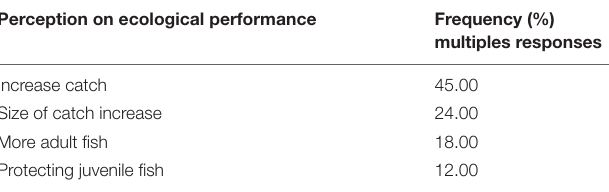
TABLE 5 | Perceptions of participants (survey) on ecological performance of seasonal monsoon fish ban (Multivariate frequency analysis). Perception on ecological